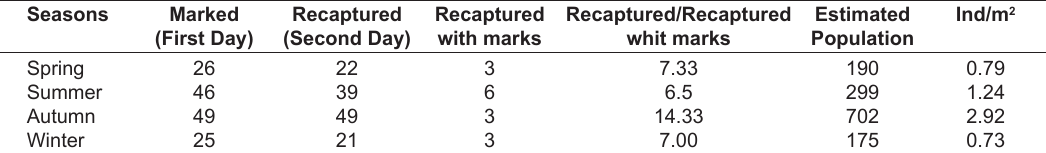
Table 2. Aegla mauinflata . Quantitative data of the Petersen estimate of population density in the Passo Taquara stream, São Pedro do Sul, Rio Grande do Sul state, Brazil.